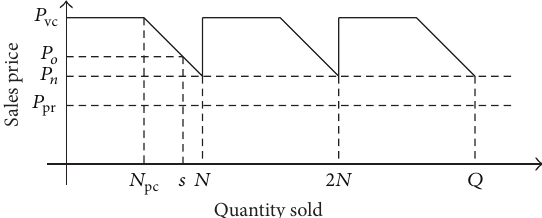
Figure 3: Modelling the situation when the sale price is variable and the quantity sold is constant in time.